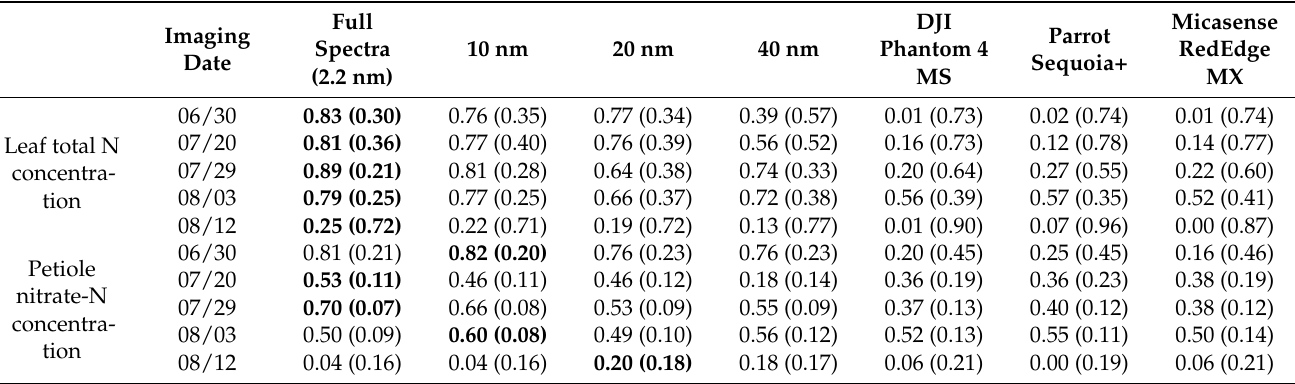
Table 5. Model performance grouped by the five imaging dates for the hyperspectral narrow and broad bands and the synthesized multispectral